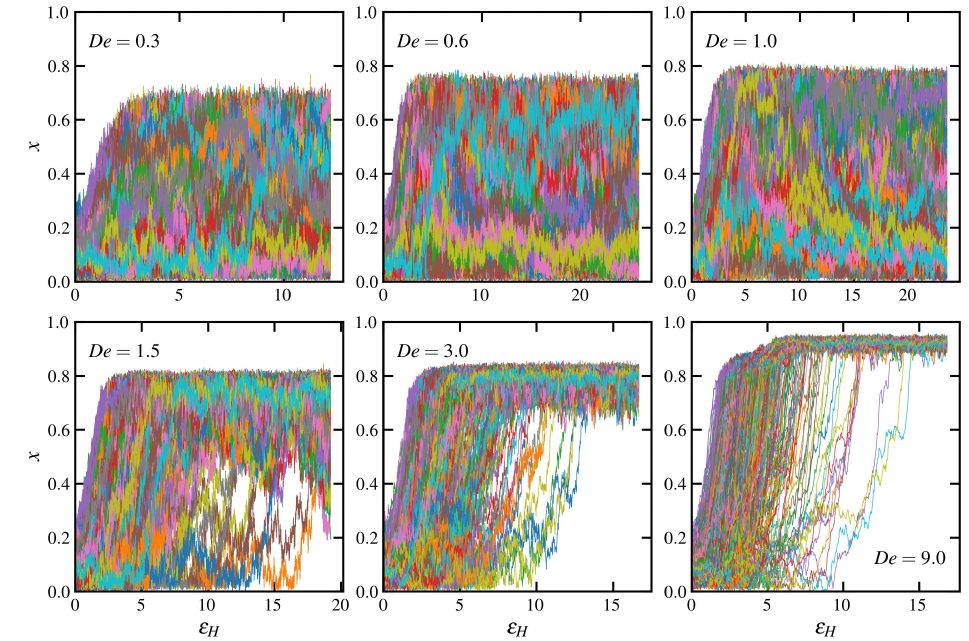
Figure 2. Time evolution of fractional extension of all molecules after startup of UEF at various De plotted in terms of Hencky strain, ε H . Each individual molecular trajectory is plotted using a line of randomly chosen